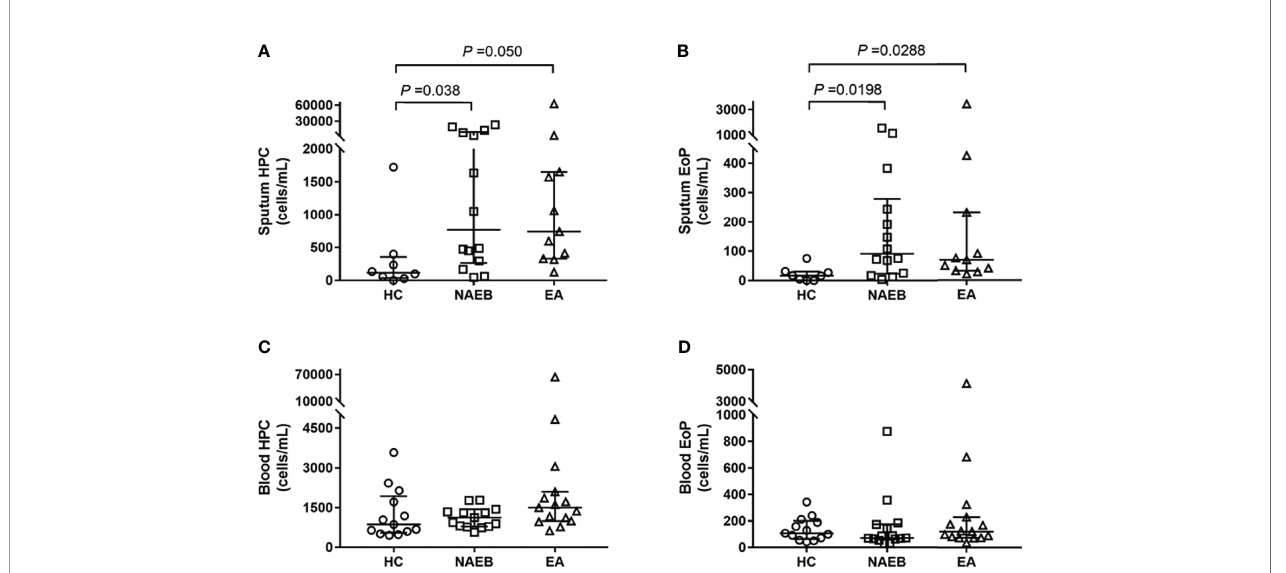
FIGURE 1 | Absolute numbers of hematopoietic progenitor cells (HPC) and eosinophilic progenitor cells (EoPs) in three groups at baseline. Absolute numbers of sputum HPC cells (A) and EoP cells (B) , and the peripheral blood HPC cells (C) and EoP cells (D) . Absolute cell numbers enumerated by fl ow cytometry are presented as cells/ml, and data are presented as median (IQR) values. HC, healthy control group; NAEB, non-asthmatic eosinophilic bronchitis group; EA, eosinophilic asthmatics